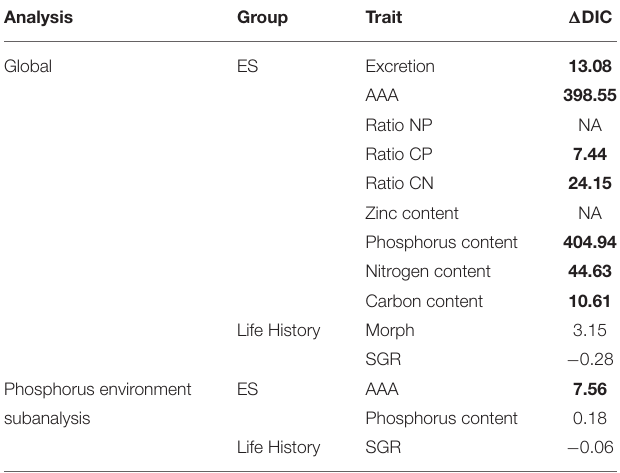
TABLE 2 | Deviance information criteria (DIC) of models for each trait with and without study type (global analysis) or stoichiometric environment (sub analysis) as a categorical